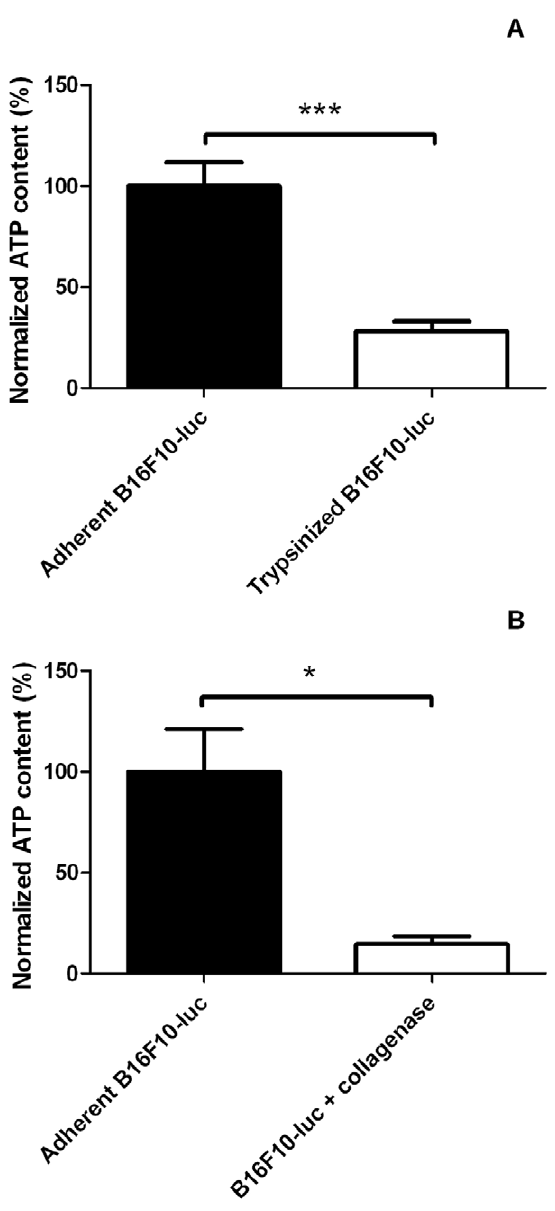
Figure 6. Influence of cell detachment on the intracellular ATP content of B16F10-luc. (A) Trypsinized cells (n=6) display a marked ATP depletion compared to adherent cells (n=6). (B) The same experiment was carried out using collagenase to harvest cells attached on collagen-coated plates (n=3 for control and B16F10 + collagenase groups) and led to similar conclusions. Results are statistically significant (*** p , 0.001 for trypsinized cells, * p , 0,05 for B16F10-luc + collagenase). Data are expressed as means 6